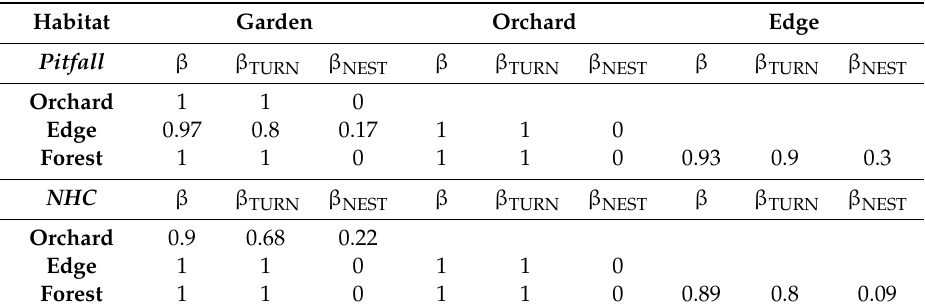
β NEST : partition of the beta diversity linked